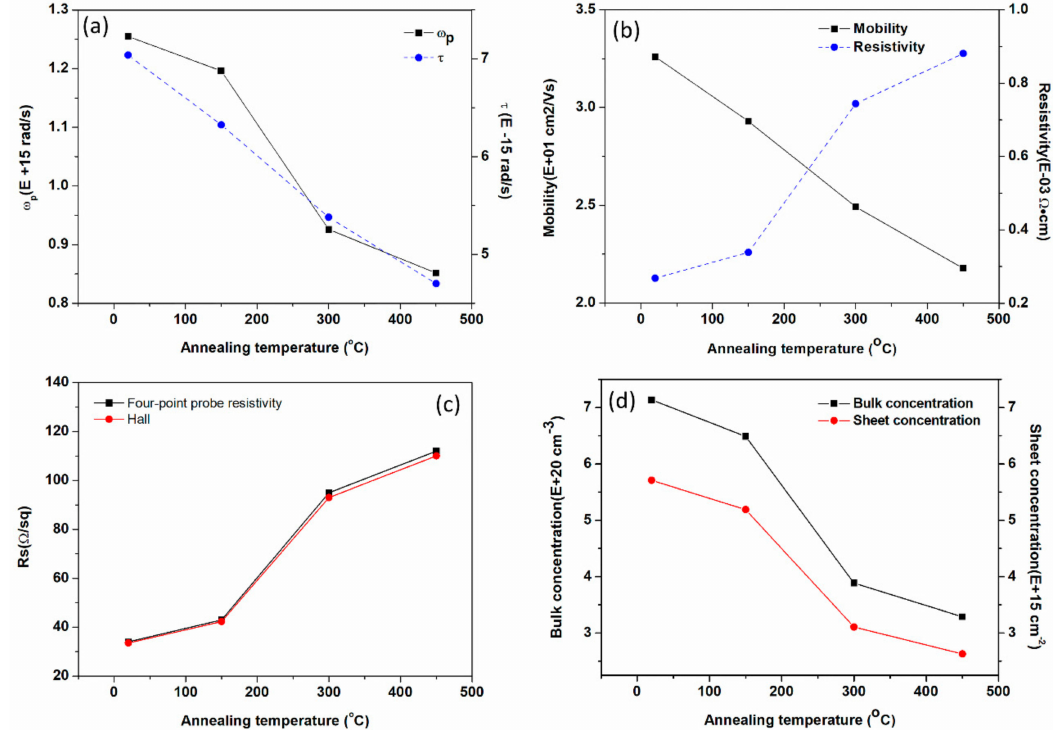
Figure 5. ( a ) The calculated plasma frequency ω p and carrier relaxation time τ as a function of